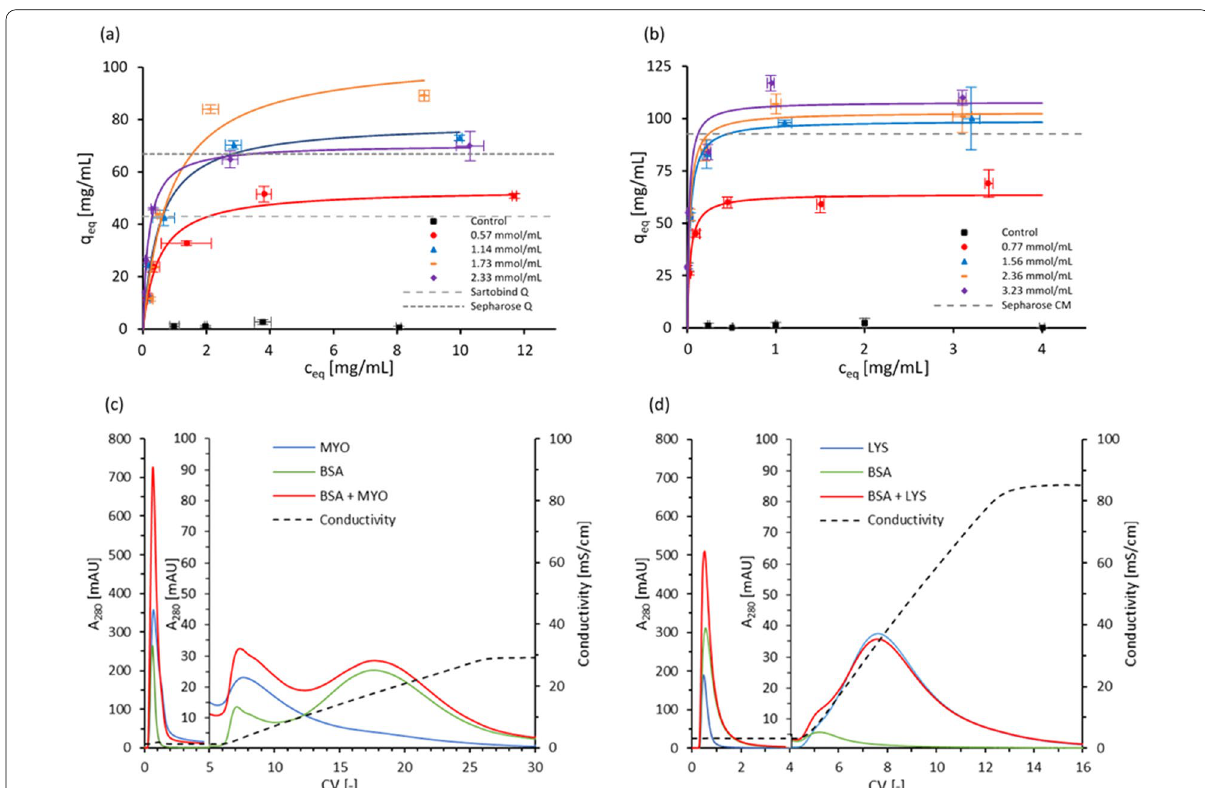
Fig. 2 Adsorption isotherms of a BSA on anion exchangers (based on AETAC monomer, adapted from Simon et al. 2020), and b LYS on cation exchangers (based on CEA monomer). Ligand densities of 0 (control), 0.57, 1.14, 1.73, 2.33 mmol/mL and of 0 (control), 0.77, 1.56, 2.36, 3.23 mmol/ mL were tested for the anion and cation exchanger, respectively. Isotherms were fitted with Langmuir model (continuous lines). Dashed lines correspond to maximum binding capacity of equivalent commercial materials (Boi et al. 2020; Staby et al., 2005). c Separation of BSA (16 mg/ mL) and MYO (6 mg/mL) on AETAC‑based anion exchangers (1.6 mL column volume (CV), 1.73 mmol/mL ligand density). 500 μL injection in binding buffer (20 mM Tris, pH 8.0) followed by linear gradient from 0 to 30% elution buffer (20 mM Tris, 1 M NaCl, pH 8.0) over 20 CV at 1.0 mL/min (75 cm/h). First peak is flow through of overloaded BSA and MYO; second and third peaks correspond to MYO elution at 7.4 CV (3.1 mS/cm) and BSA elution at 18.7 CV (19.0 mS/cm) in line with the electrostatic interactions established at the buffer’s pH of 8 (pI BSA 4.8; pI MYO 7.0). d Separation of = = BSA (16 mg/mL) and LYS (4 mg/mL) on CEA‑based cation exchangers (2.5 mL CV, 3.23 mmol/mL ligand density). 300 μL injection in binding buffer (25 mM phosphate, pH 7.4) followed by linear gradient from 0 to 100% elution buffer (25 mM phosphate, 1 M NaCl, pH 7.4) over 20 CV at 1.0 mL/ min (75 cm/h). First peak is flow through of non‑binding BSA (pI BSA 4.8) and overloaded LYS; second peak corresponds to LYS elution at 7.6 CV = (33.4 mS/cm) in line with the electrostatic interactions established at the buffer’s pH of 7.4 (pI LYS =